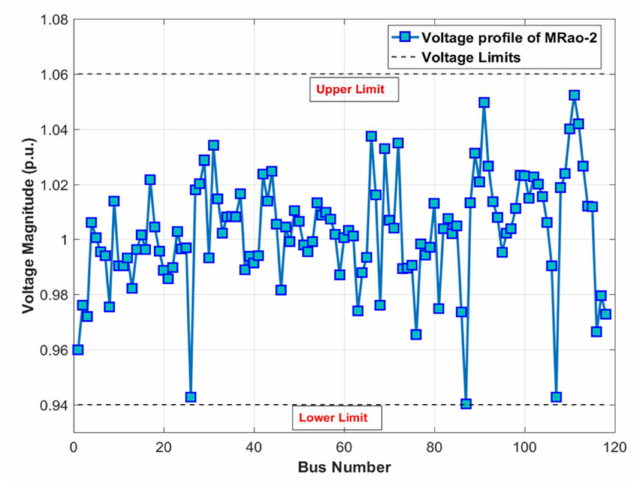
Figure 13. The voltage profile of the MRao-2 for case 4.